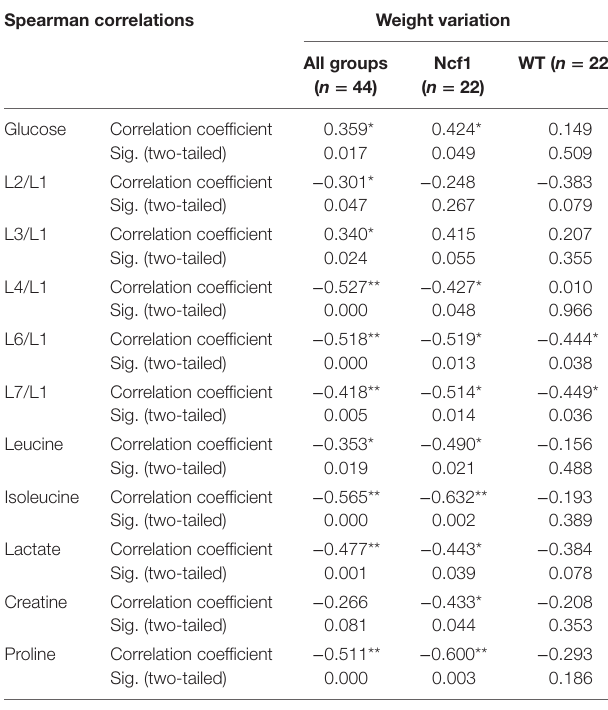
TaBle 2 | Summary of all statistically significant Spearman correlations for dysplasia score vs metabolite concentrations considering either all mice pooled together or Ncf1-mutant (Ncf1) vs wild-type (WT) groups.